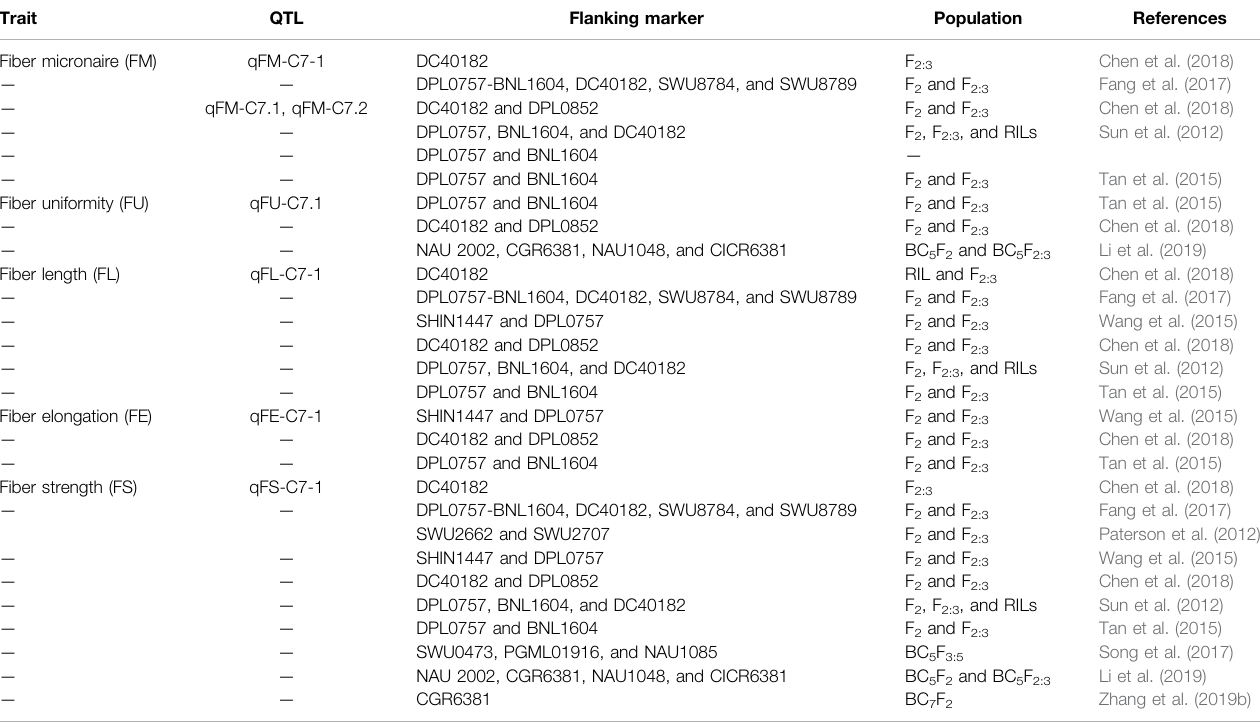
TABLE 4 | Prospective QTLs of fi ber development located on chromosome 7 in G. hirsutum using SSR